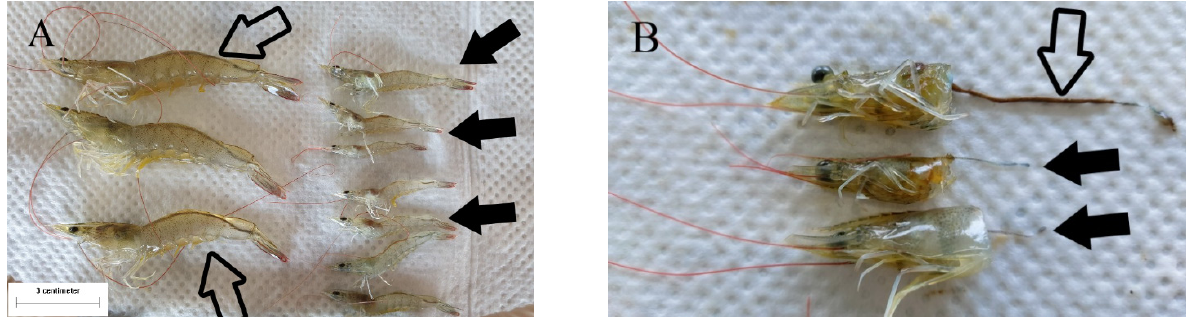
Figure 1. Gross observations of shrimp with different growth patterns. ( A ) Pacific whiteleg shrimp with normal growth (open arrows) and with delayed growth (solid black arrows). ( B ) Empty intestines (solid black arrows) in contrast to the intestine filled with digestive substances (open arrow).